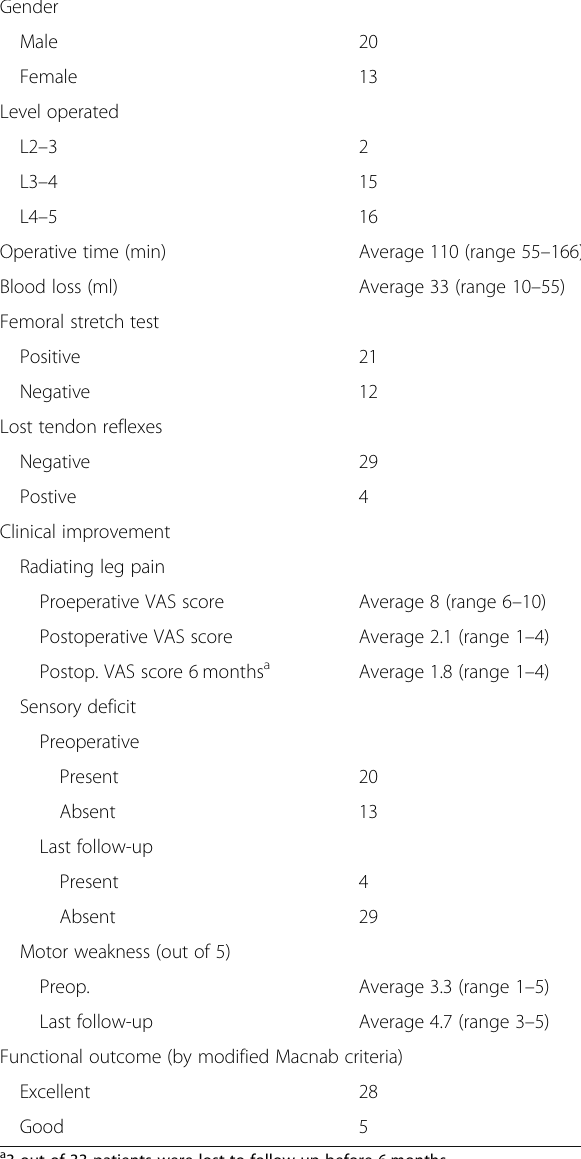
Table 2 Patients ’ characteristics and